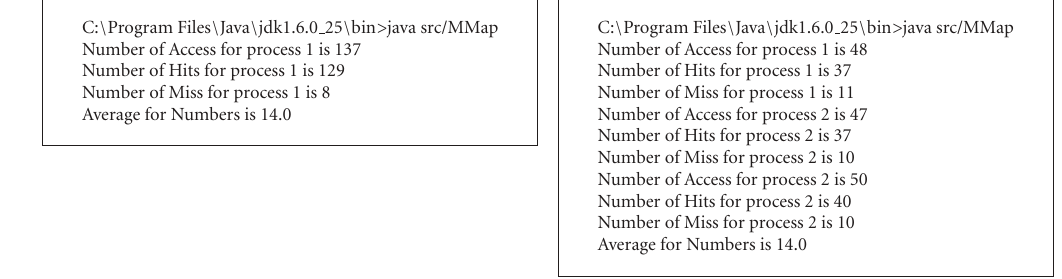
Figure 13: Screen shot for plain and interleaved execution of average calculation on memory map simulator with block size of 32 bits.